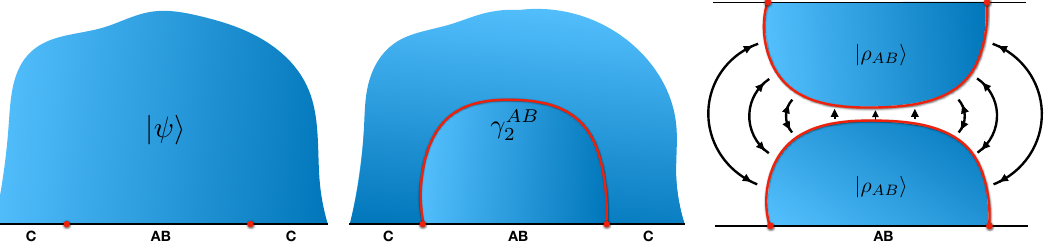
Figure 18 . Prescription for obtaining the bulk geometry dual of operator state . Left: start from the bulk dual of j i the dual geometry and settle down; Right: spatial geometry dual to two copies of the relevant bulk regions across (cid:13) AB